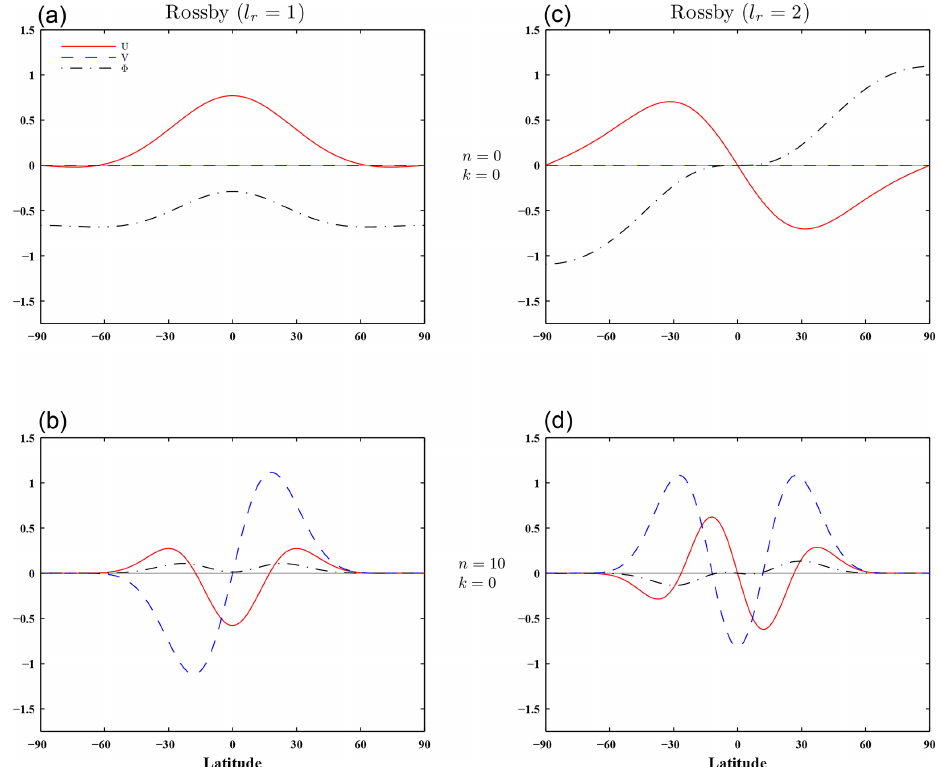
Figure 6. Meridional structures of the barotropic ( k = 0, h 0 (cid:39) 9 . 8km) Hough harmonics for two Rossby modes, l r = 1 (a, b) and l r = 2 (c, d) , and two zonal wavenumbers, n = 0 (a, c) and n = 10 (b, d) . The equivalent height h 0 was obtained by solving the vertical structure equation with boundary conditions (14) and